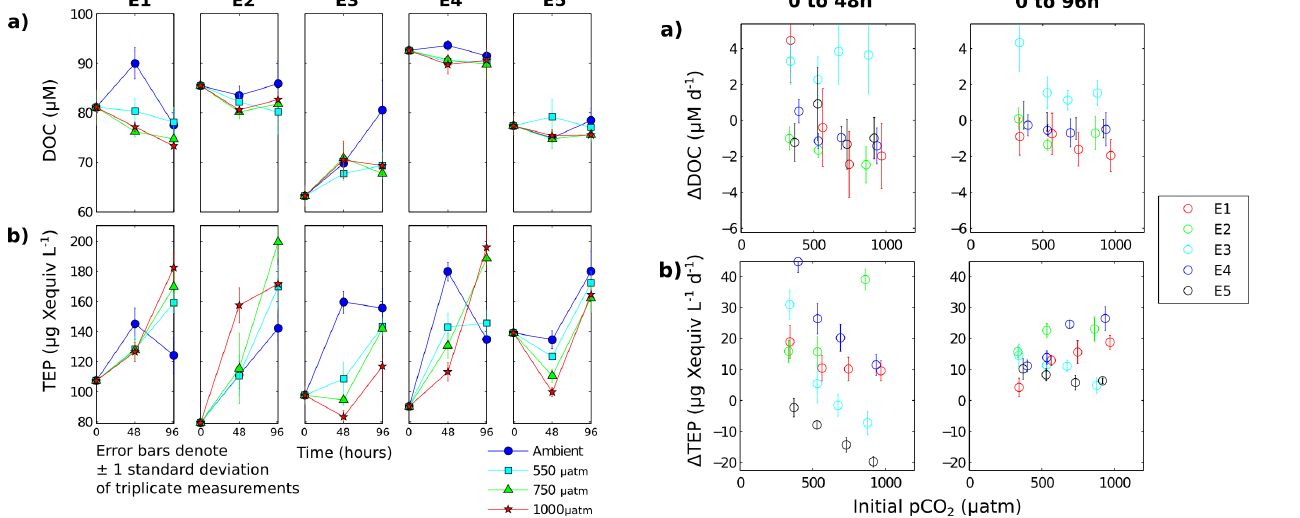
Figure 4. Evolution of (a) dissolved organic carbon (DOC;µM) and (b) transparent exopolymer particles (TEPs; µgXequivL − 1 ) in five bioassay experiments across three time points for all p CO 2 treat- ments. Legend shows the colours and symbols used to denote the different p CO 2 treatments.